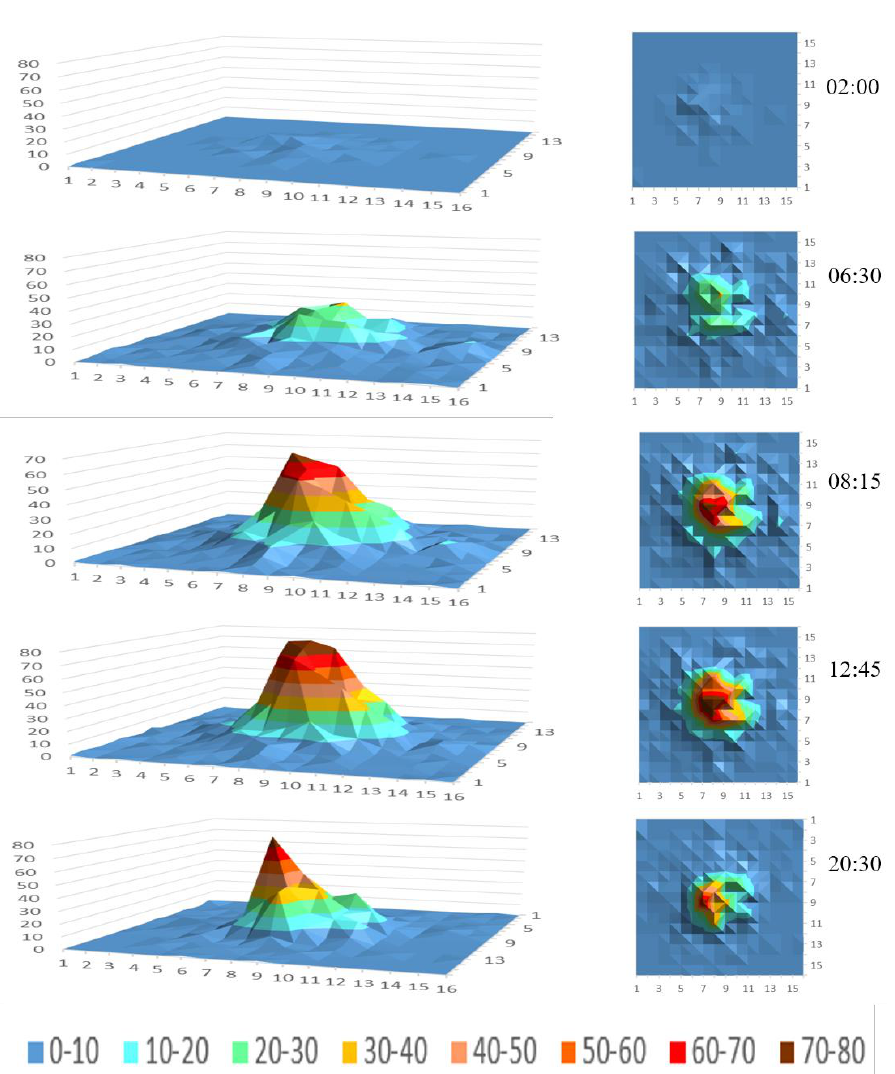
Figure 7. Thermal map of the prediction results at different time periods.